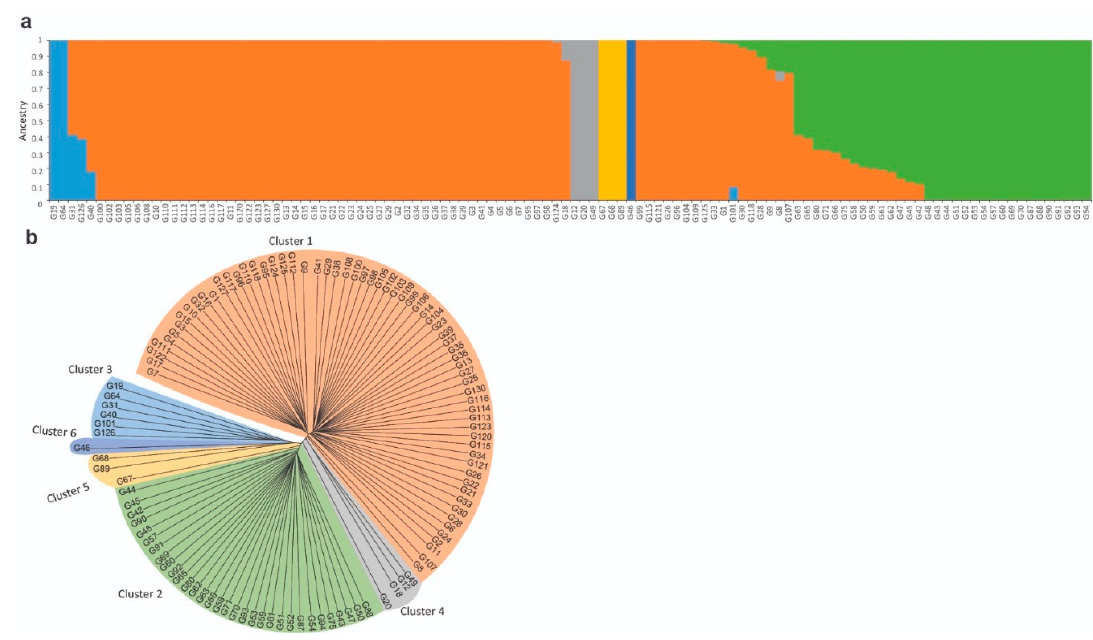
Figure 2. Population structure analysis showing the admixture proportions of the 112 fenugreek genotypes ( a ), and the SNP-based phylogenetic analysis ( b ). In both panels, genotype IDs (in the format G+number) match those presented in Table S1.